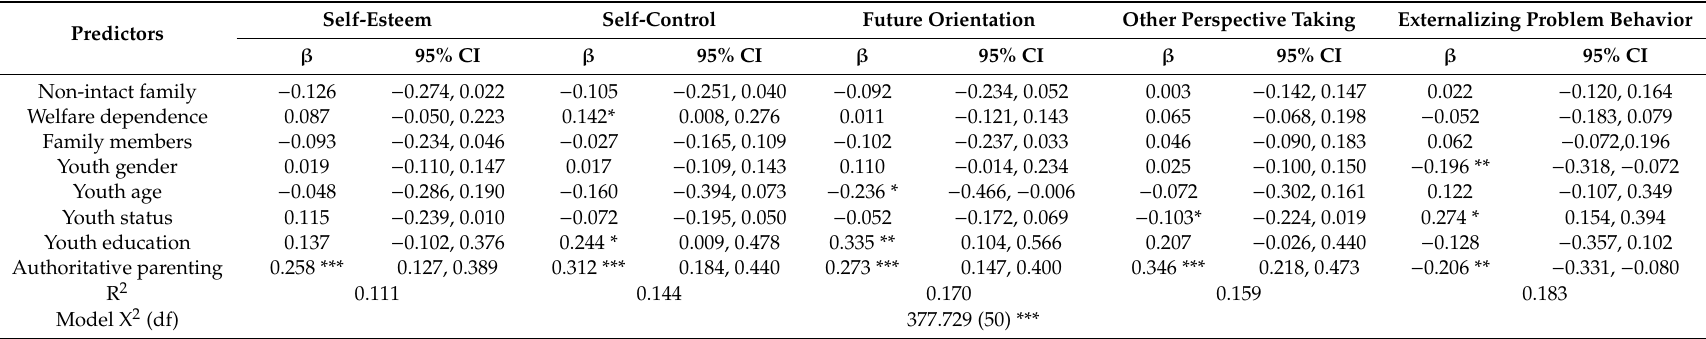
Table 2. Multivariate linear regression modeling predicting self-esteem, self-control, future orientation, other perspective taking and externalizing problem behaviors of youth by authoritative parenting.